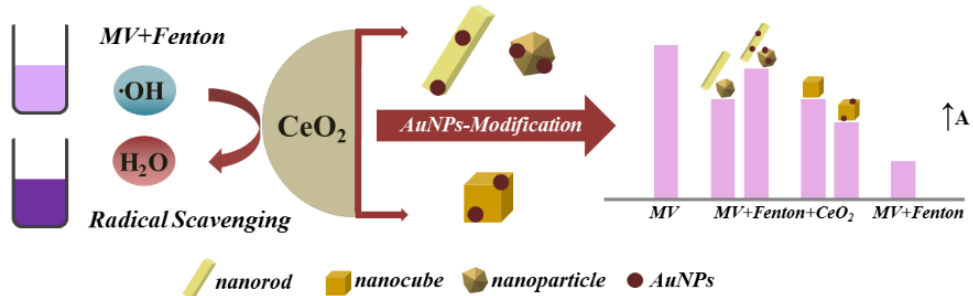
Figure 18. Schematic representation of the CeO 2 surface-modification with AuNPs and their concentration-dependent antioxidant activity (A ↑ ). Reprinted (adapted) with permission from [101]. Table 3. List of (i) engineered nanoantioxidants developed through non-covalent surface modifica- tion and (ii) nanozymes.